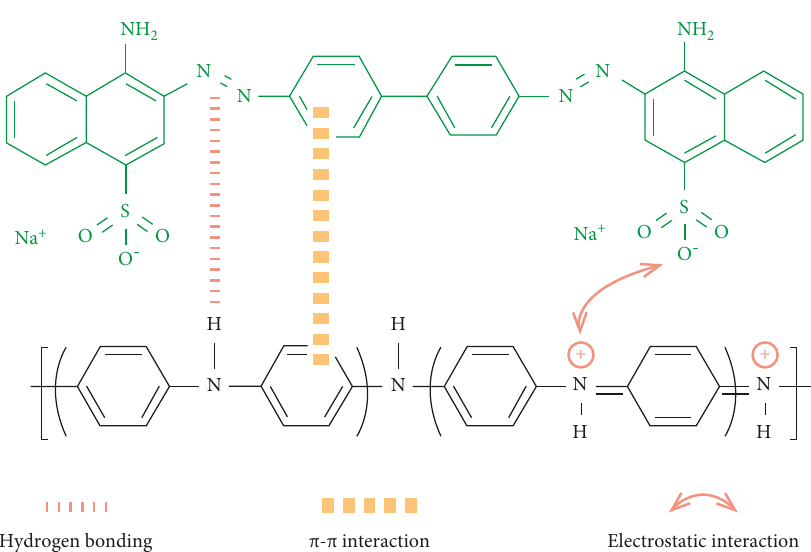
Figure 9: Plausible mechanism of Congo red adsorption by GluP composites.